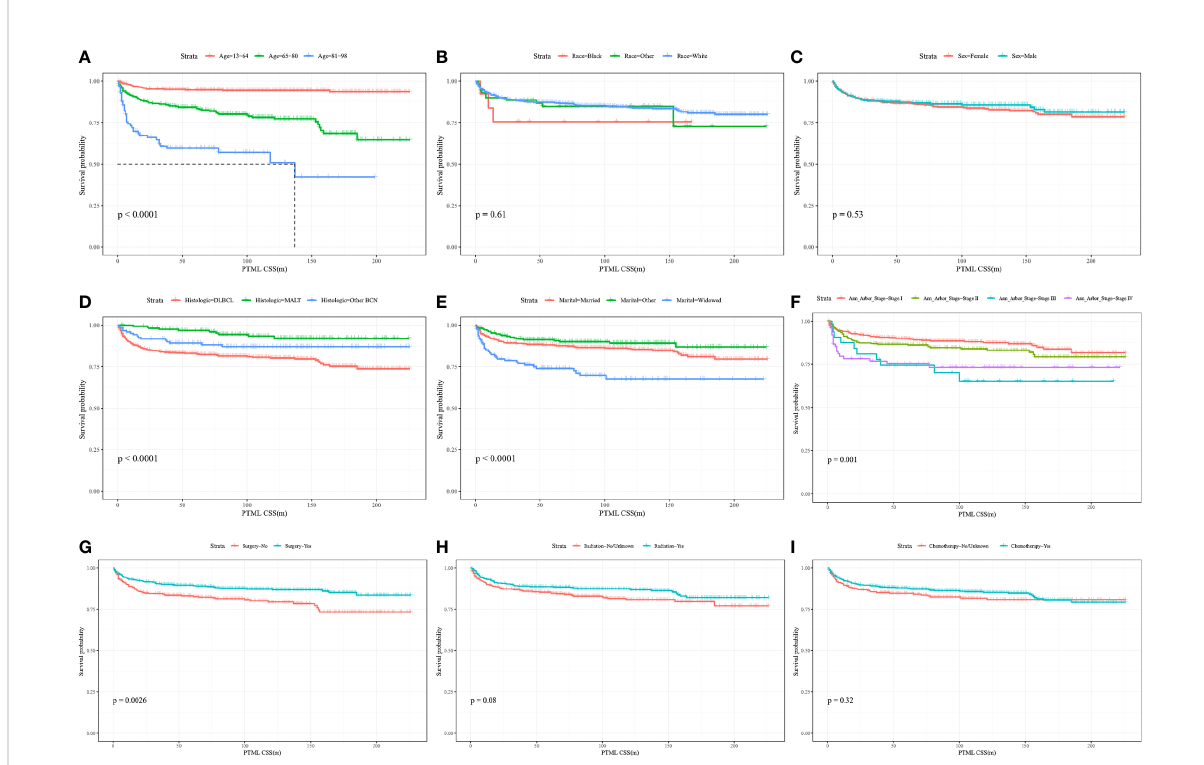
FIGURE 2 Kaplan-Meier curves of BC-PTML-speci fi c survival in patients with age at diagnosis (A) , race (B) , sex (C) , histologic type (D) , marital status (E) , Ann Arbor Stage (F) , surgery of thyroid (G) , radiation (H) and chemotherapy (I)